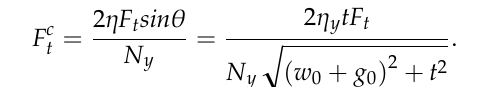
Figure 6. The contact force produced by the tension force of a yarn (different weave pattern).